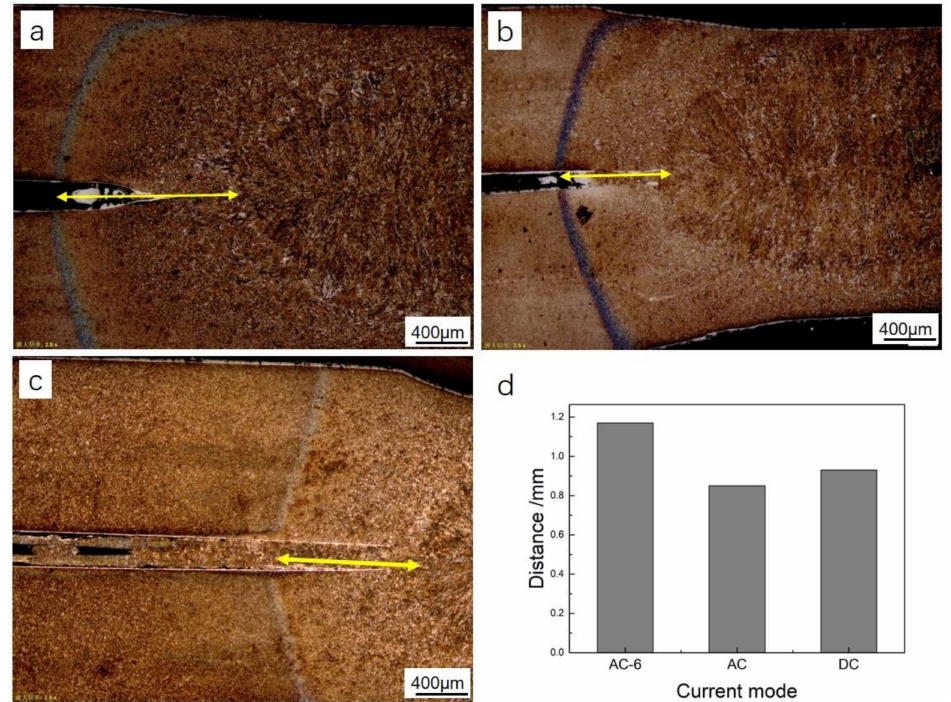
Figure 11. Comparison of plastic zone size under three conditions with different current